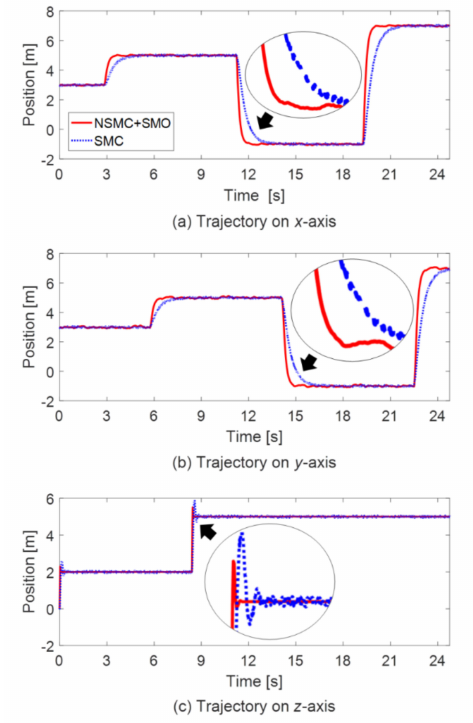
Figure 8. Quadrotor’s trajectory on each